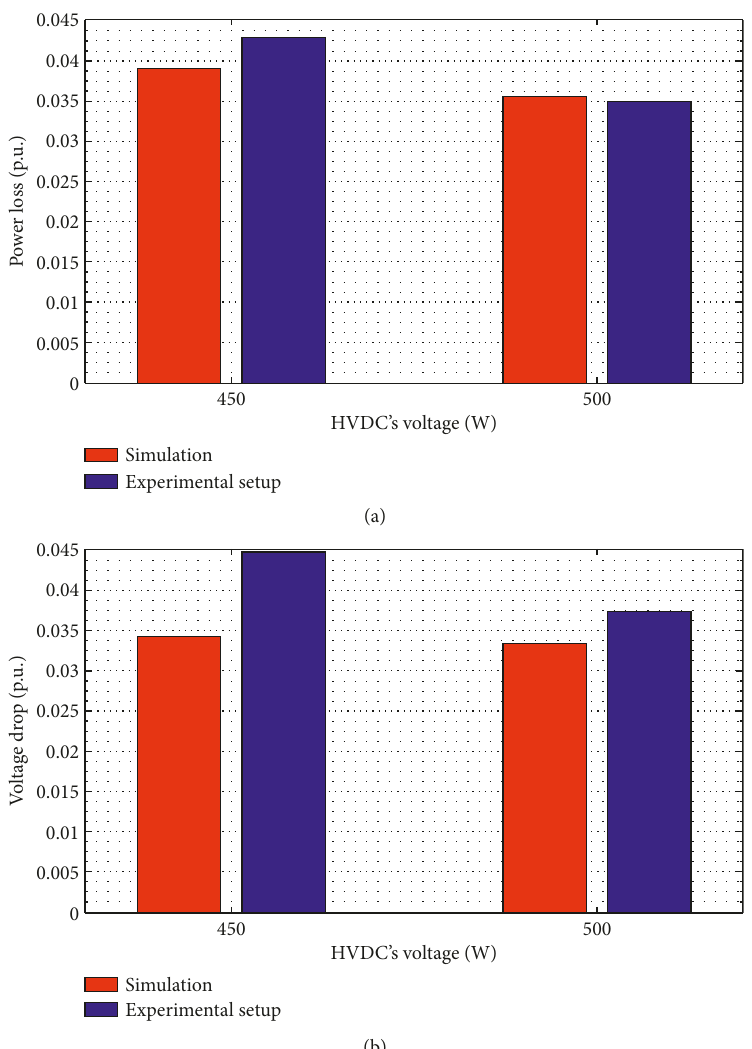
Figure 20: Comparison of the power losses and voltage drops based on the voltage conditions. (a) Comparison of the power losses and (b) comparison of the voltage drops.